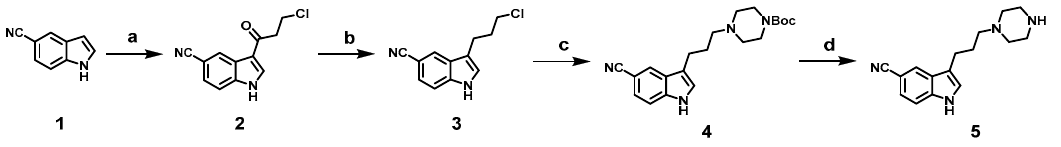
Scheme 1. Synthesis of intermediate 5 . Reagents and conditions: ( a ) 3-chloropropionyl chloride, AlCl 3 ,